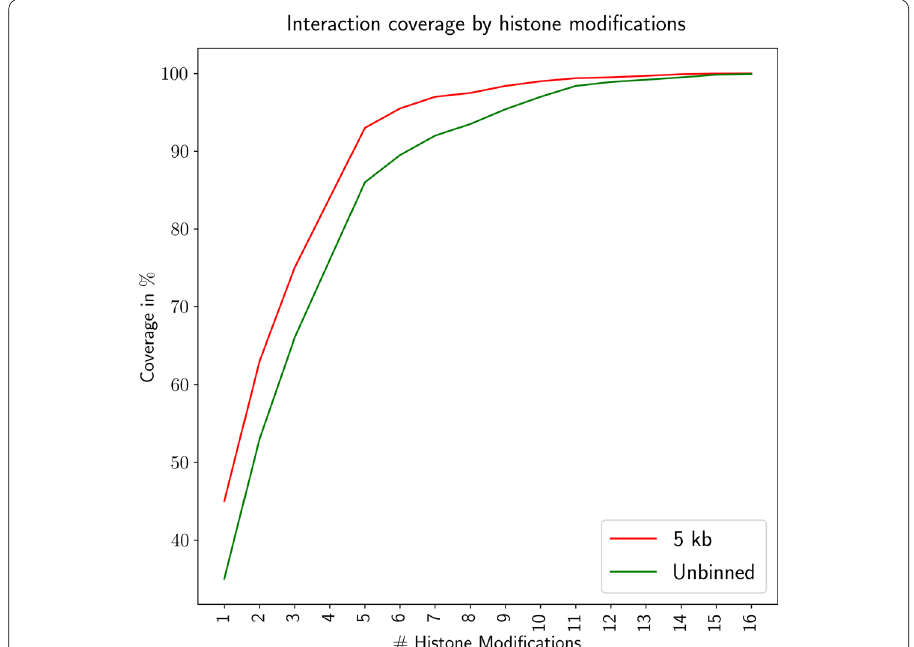
Fig. 1 Hi–C coverage by percentage by increasing number of histone modifications on 5 kb and unbinned